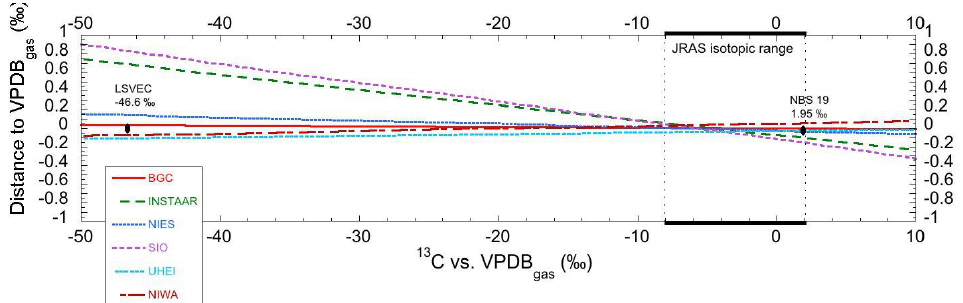
Table 3.  18 O results. Linear regression resulting from comparing local scales to JRAS-06.